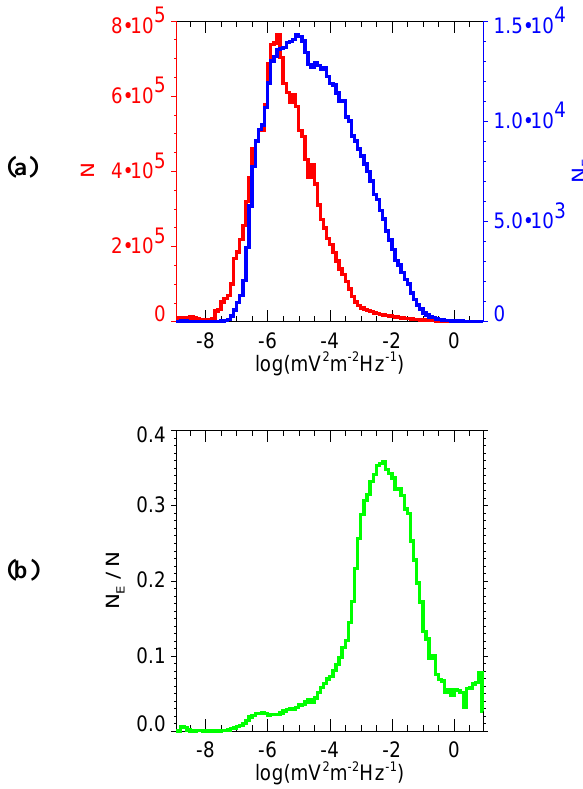
Fig. 6. The same as in Fig. 3, but for the sum of the power-spectral densities of the two measured components of electric field fluctua-